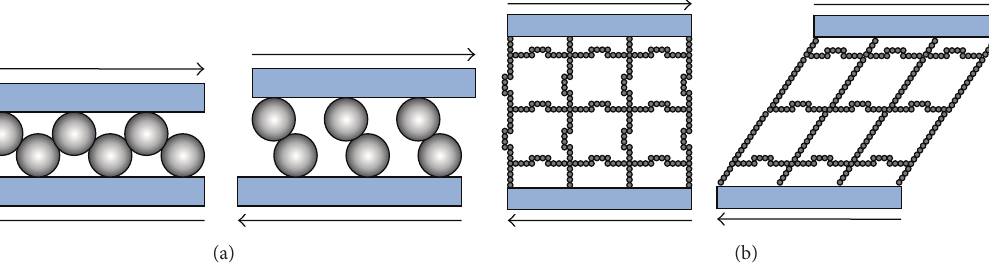
Figure 6: Schematic of the response of two different types of particle system to shear. (a) Cohesionless granular array (cf. [41]). (b) Colloidal particulate network formed by aggregation (cf. [157]). Normal forces are not shown but are described in the text. It is assumed that wall slip is